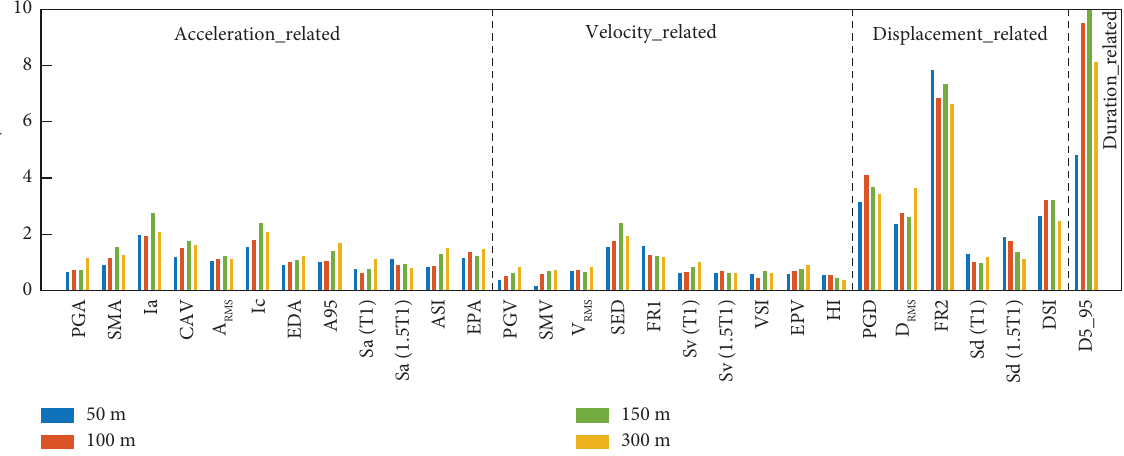
Figure 11: Profciency comparison of 29 candidate IMs against FOS for the slopes with diferent mining